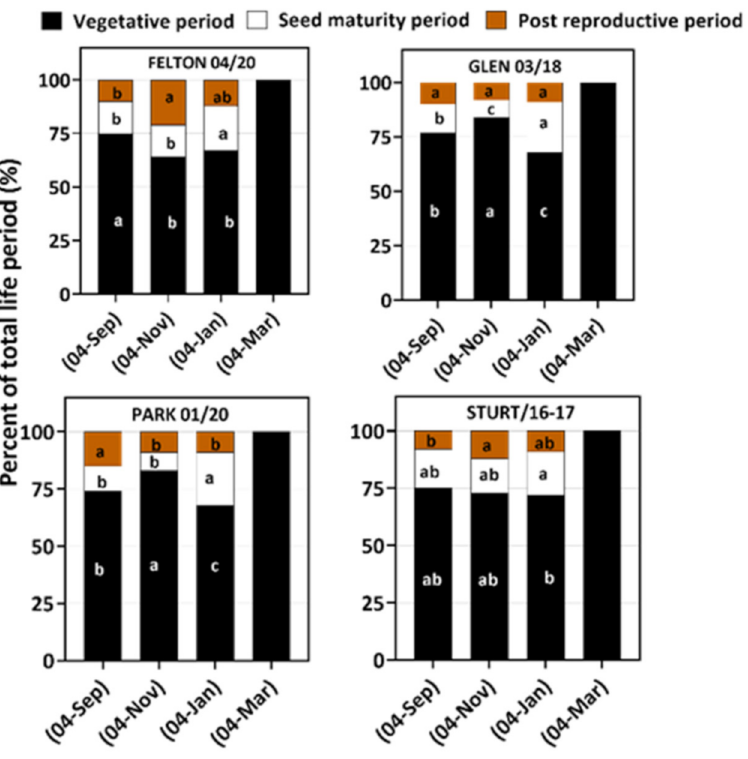
Figure 2. The percentage of life period at the vegetative, seed maturity, and post-reproductive stages of four feathertop Rhodes grass populations at four sowing times. Different letters for the same period of development indicate significant differences with a 5% level of significance. Here 04-Sep = 4 September, 04-Nov = 4 November, 04-Jan = 4 January, 04-Mar = 4